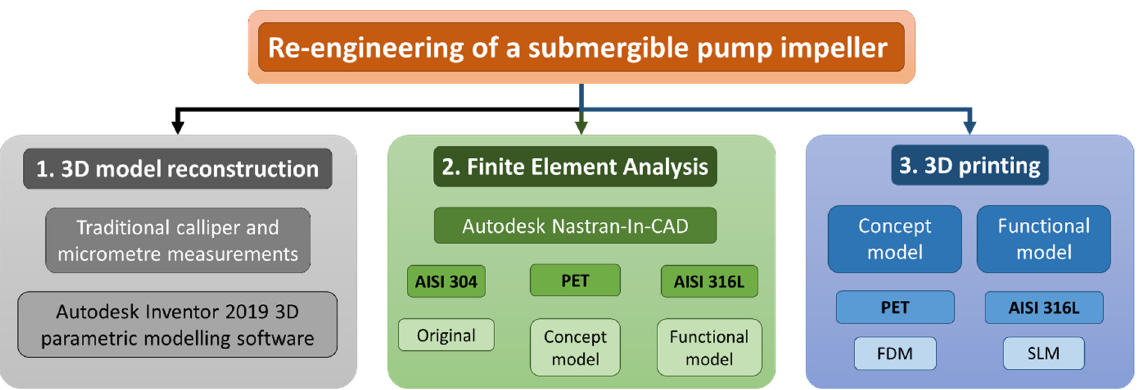
Figure 1. Flowchart of the activities carried out for the re-engineering of the impeller of a submersible electric pump.